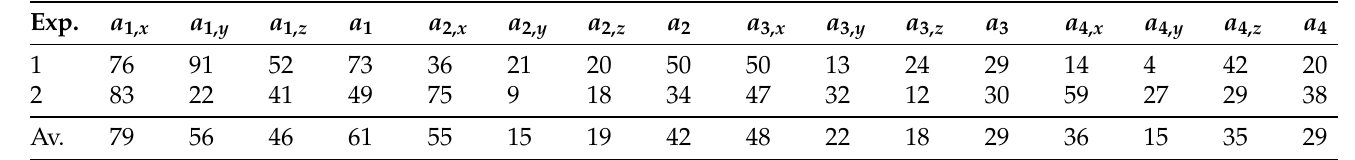
Table 12. ET amplitude reduction rates during the Prototype (B) Closed-Loop evaluation.